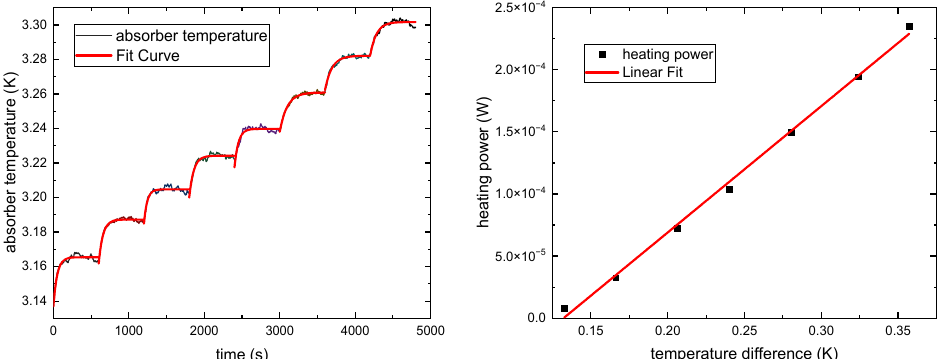
Figure 4. Experimental data for determining time constant τ of the cavity absorber ( left ) and correla- tion between heating power and cavity absorber temperature to calculate the thermal conductance G of the heat link ( right